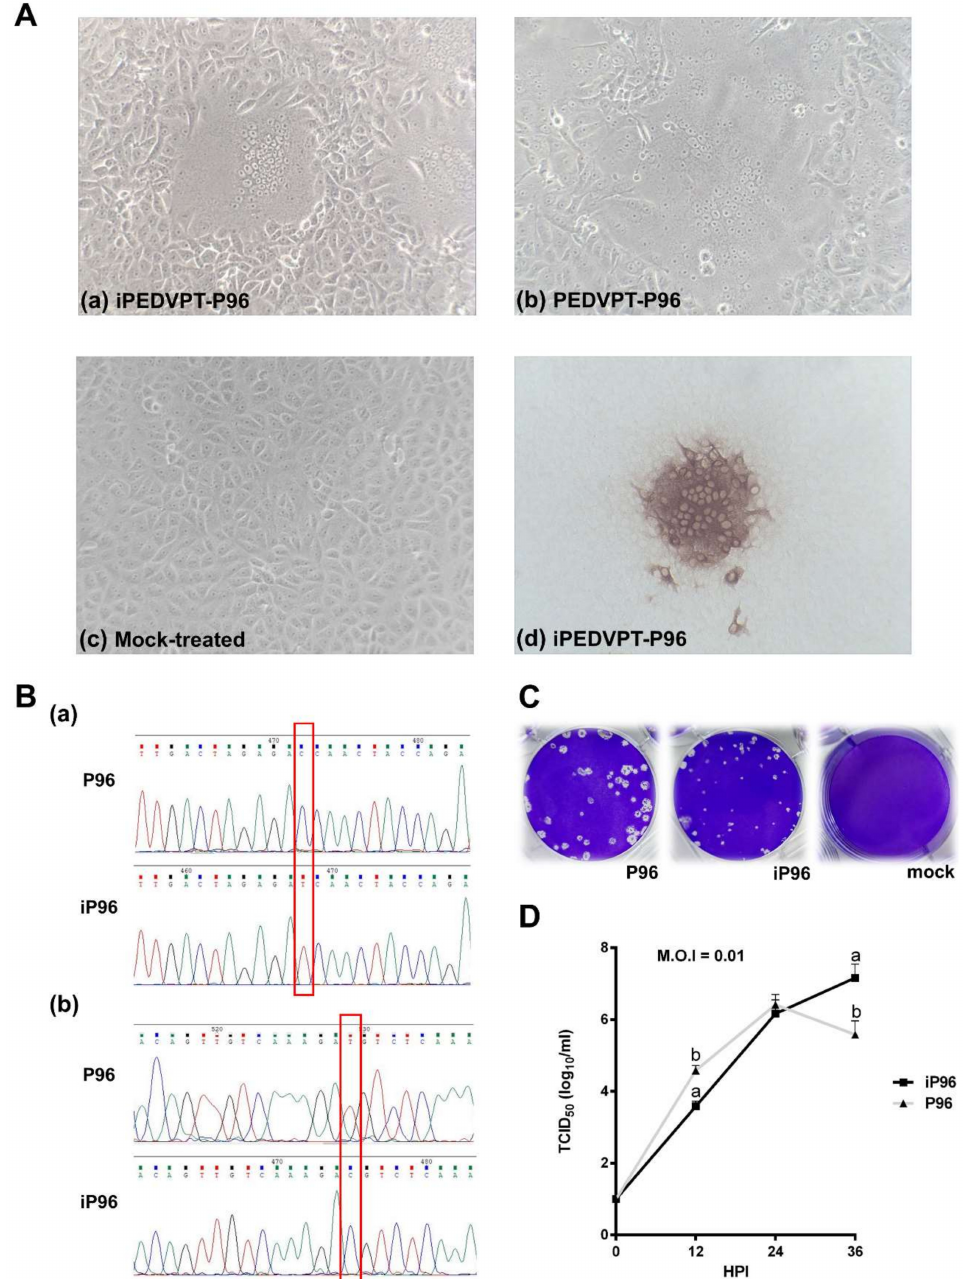
Figure 2. The in vitro characterization of the recombinant iPEDVPT-P96 virus. ( A ) The cytopathic effect in Vero cells infected with the iPEDVPT-P96 virus ( Aa ), PEDVPT-P96 virus ( Ab ), or mock-treated ( Ac ), and the immunocytochemistry ( Ad ) detecting PEDV N protein. The microphotographs were taken at 400 × magnification. ( B ) Sequence analysis indicated the appropriate marker mutations of cysteine to thymidine at nucleotide site 24341 and, thymidine to cysteine at nucleotide site 24841, as indicated by the red boxes. ( C ) Plaque morphologies of Vero cells infected with the iPEDVPT-P96 virus, PEDVPT-P96 virus, or mock-infected, acquired after three days of incubation. Note that the iPEDVPT-P96 infection resulted in more consistent plaque sizes. ( D ) The growth kinetics of the iPEDVPT-P96 and PEDVPT-P96 viruses in the Vero cells after infection at 0.01 MOI. The titers of each virus at the indicated time points (hours post-infection; HPI) were expressed as the mean ± standard deviation. Different alphabetic letters indicated significant differences between the iPEDVPT-P96 or PEDVPT-P96 groups ( p <